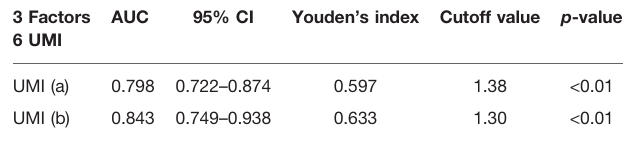
TABLE 6 | Results of ROC analysis on tear and